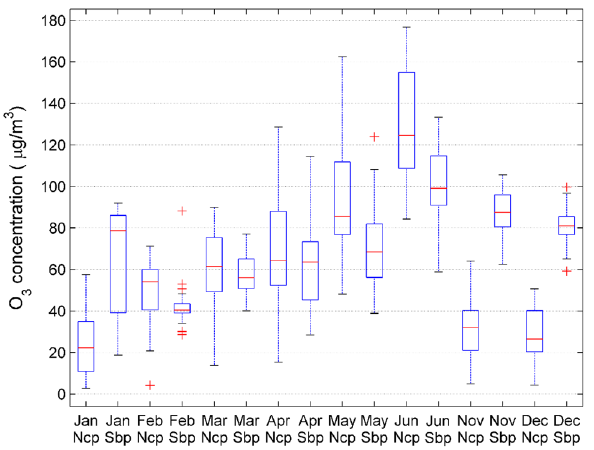
Figure 3. Compare the O 3 concentration of national control points (Ncp) and self-built points (Sbp) on a monthly basis. Note that there is no data from July to October.